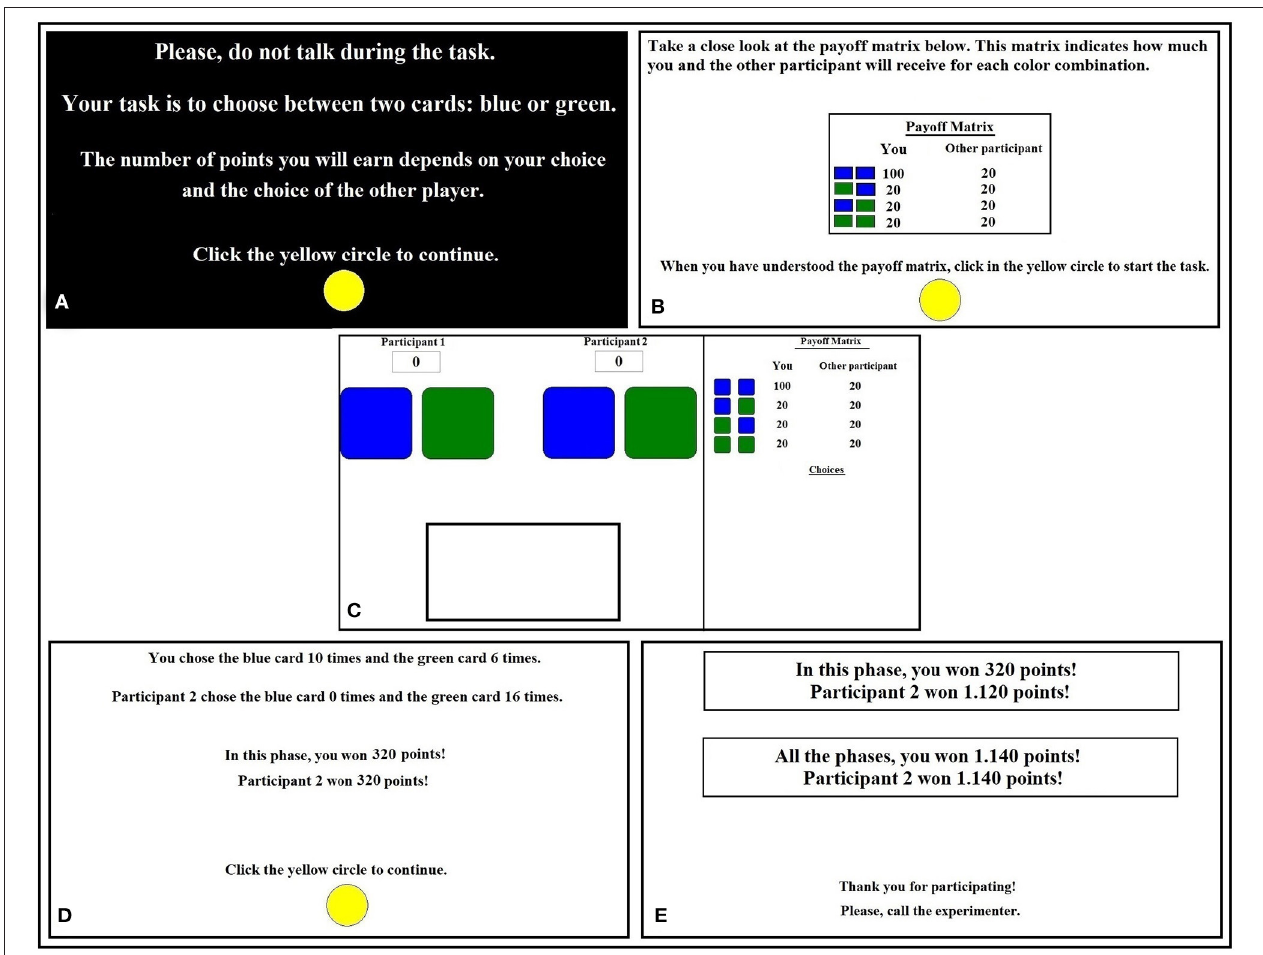
FIGURE 2 | Screens shown during the experimental session. (A) Presented a summary of the instructions. (B) Presented the payoff matrix. Only the payoff matrix used in the cooperative interaction and uncooperative interaction condition is presented. (C) Presented the experimental task. (D) Presented a matrix of points corresponding to the new condition. (E) Presented a final screen showed the number of points gained in the previous condition as well as the total number of points obtained in the